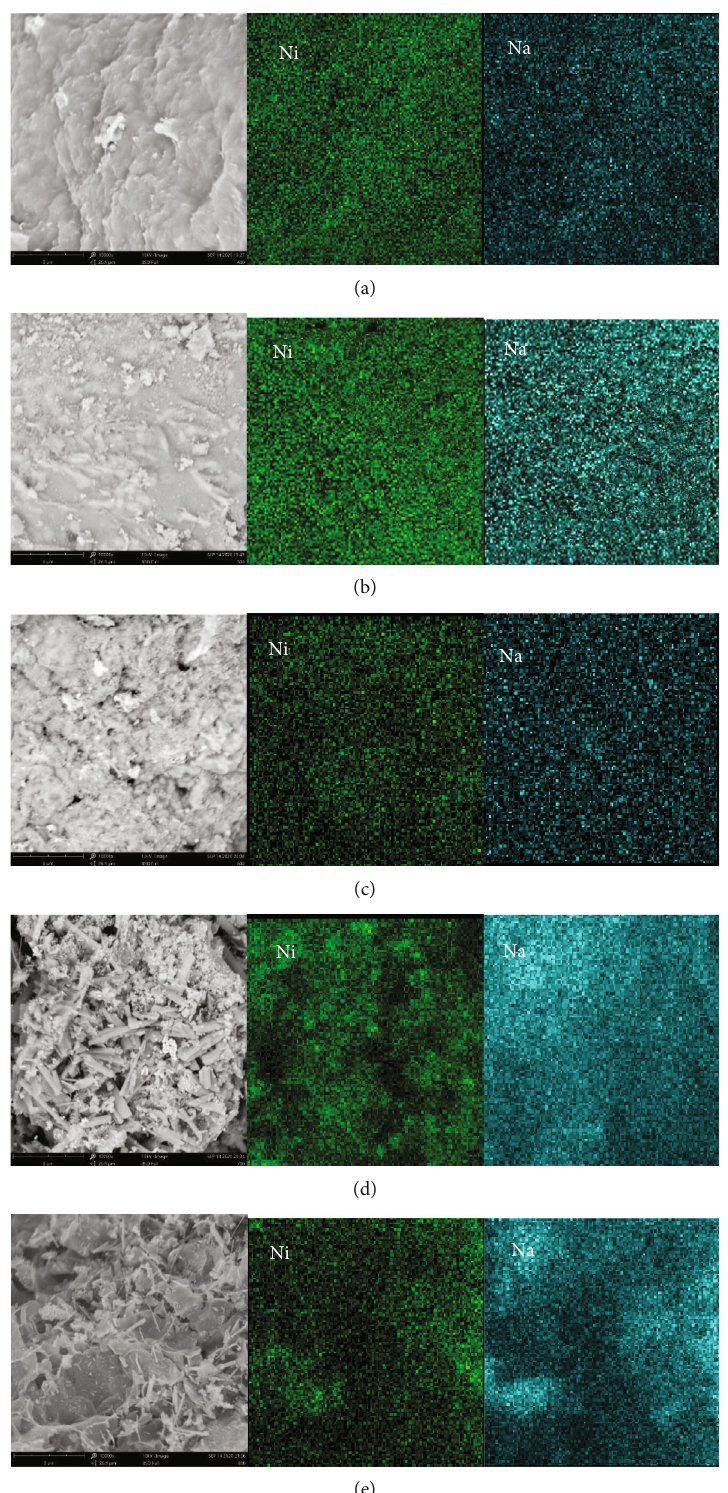
Figure 1: SEM images and corresponding EDX elemental mapping of (a) DW-Ni-400, (b) DW-Ni-500, (c) DW-Ni-600, (d) DW-Ni-700, and (e)